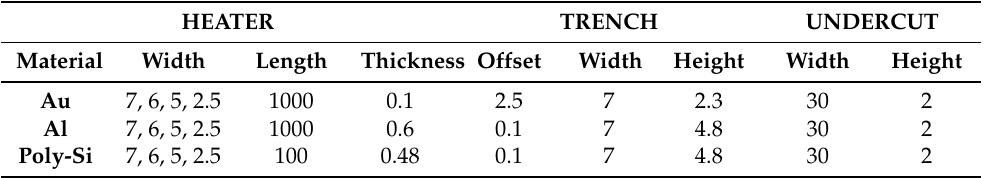
Table 2. Dimensions [ µ m] of the heater, trench, and undercut for the three heating element materials. HEATER TRENCH UNDERCUT Material